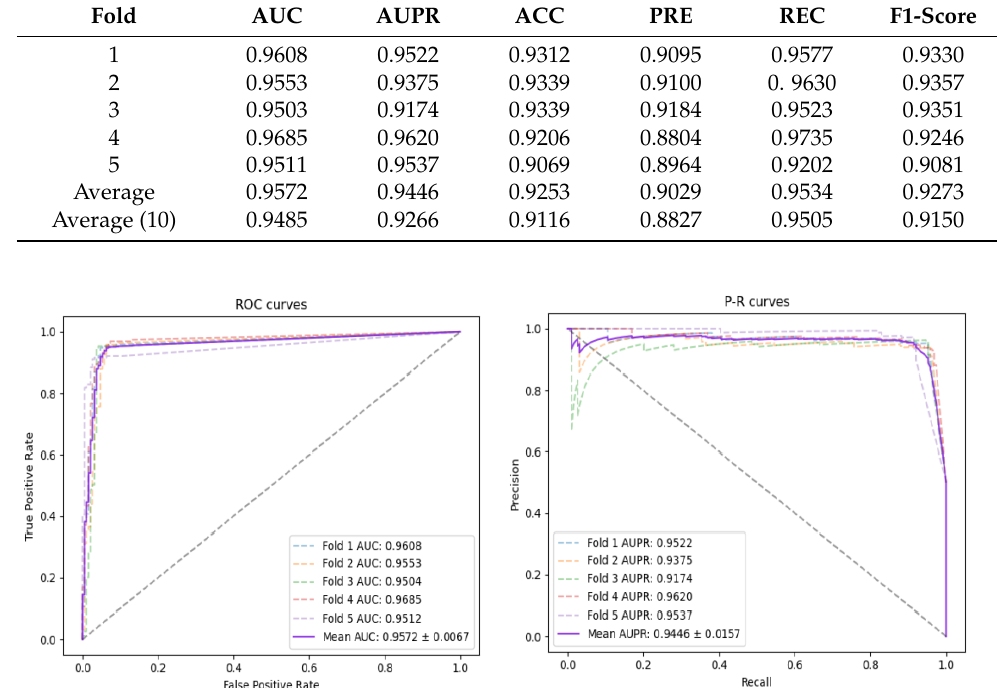
Figure 6. AUC and AUPR curves of FFCV obtained by GGCDA on DATA. Table 4. Results of FFCV on DATA achieved by GGCDA.